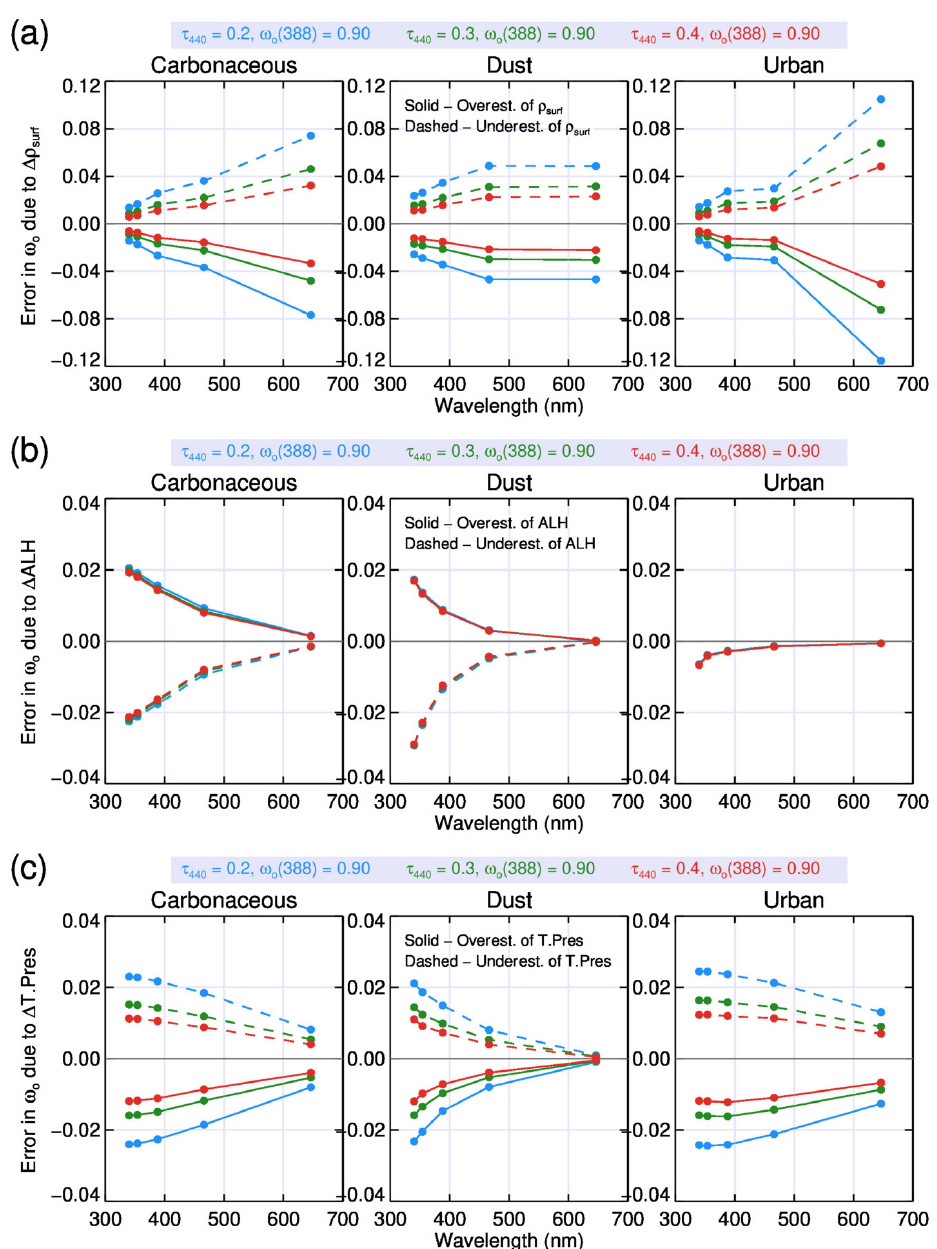
Figure 8. Theoretical uncertainty in SSA retrievals due to changes in (a) ± 0 . 01 surface reflectance, (b) ± 1km ALH, and (c) ± 12hPa surface pressure. Solid and dashed lines represent the overestimation and underestimation of the corresponding input variable.